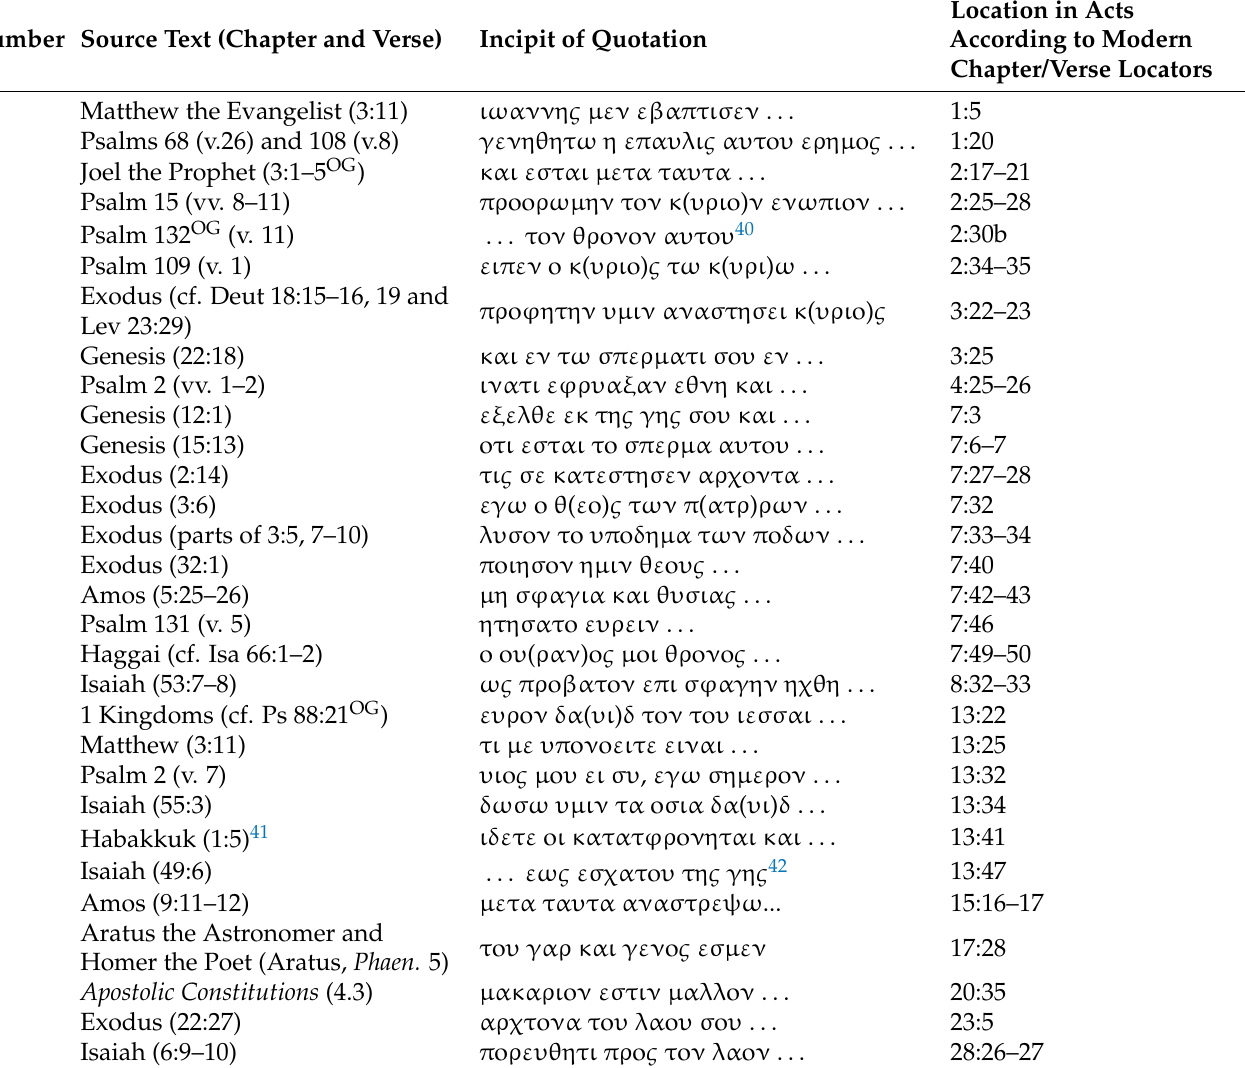
Table 2. The long quotation list to Acts in GA 1162